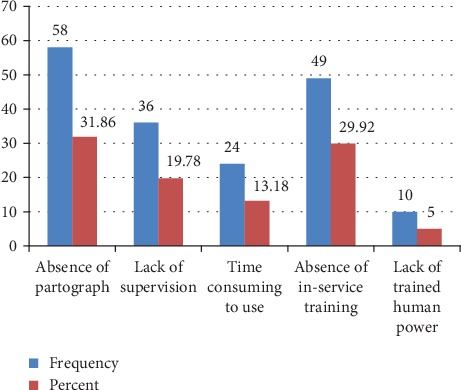
Reasons for not using the partograph by obstetric care providers of public health institution in Hadiya Zone, SNNPR Ethiopia (2019).